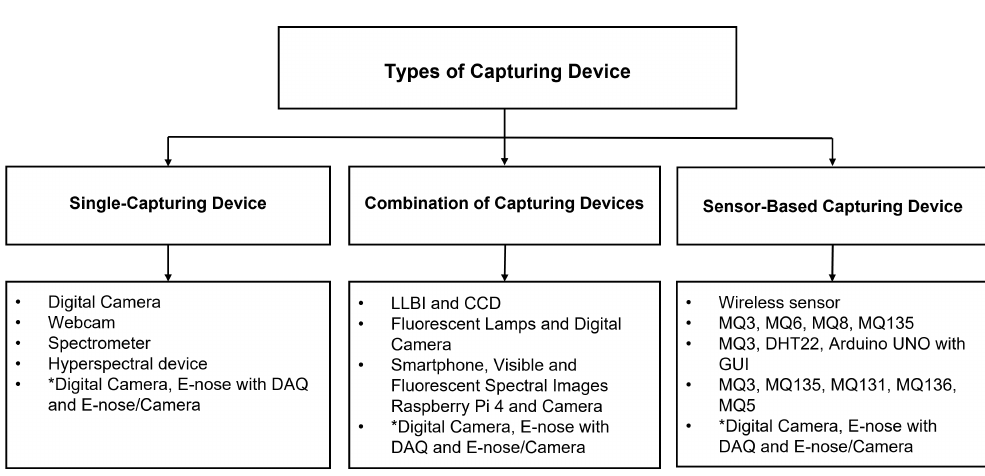
Figure 3. Types of capturing devices used for the detection of banana ripeness studies (* represented the study approaches in all three